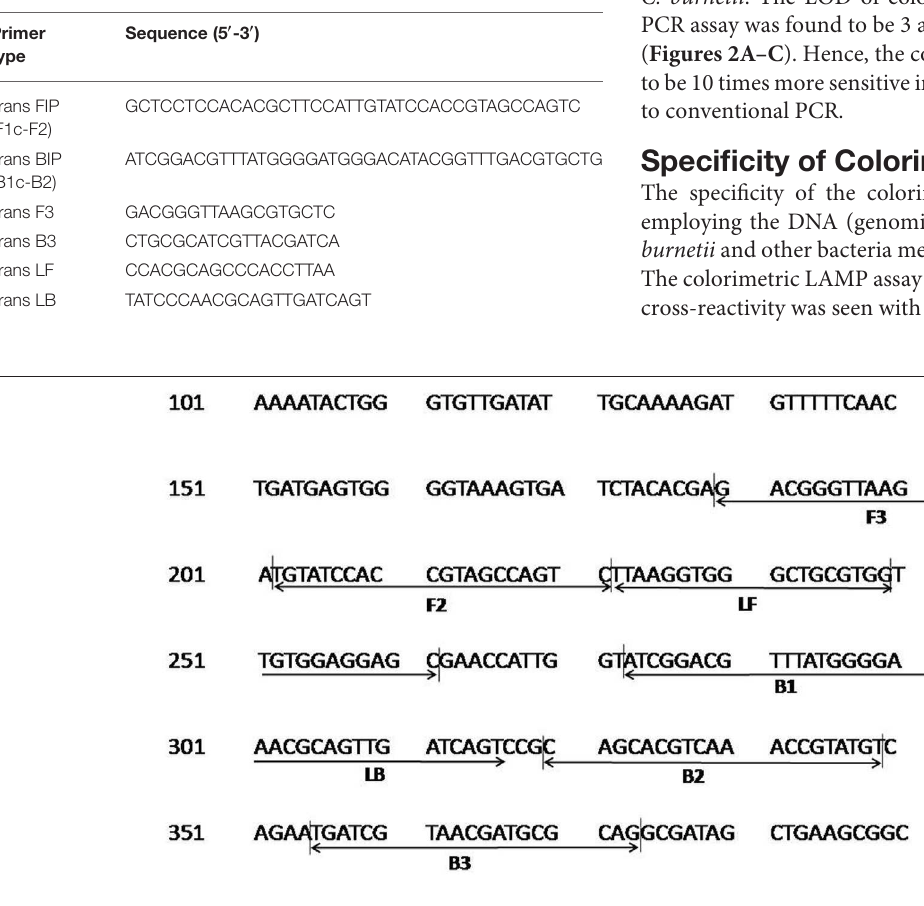
FIGURE 1 | Nucleotide sequence of the transposase gene insertion element IS 1111a of C. burnetii used for designing the LAMP primers. Numbers on the left correspond to the positions in the transposase gene (GenBank, accession no. AE016828.2). The locations of the target sequences are underlined with an arrow. FIP consists of the F1c and F2 sequences, and BIP consists of B1c and B2 sequences.